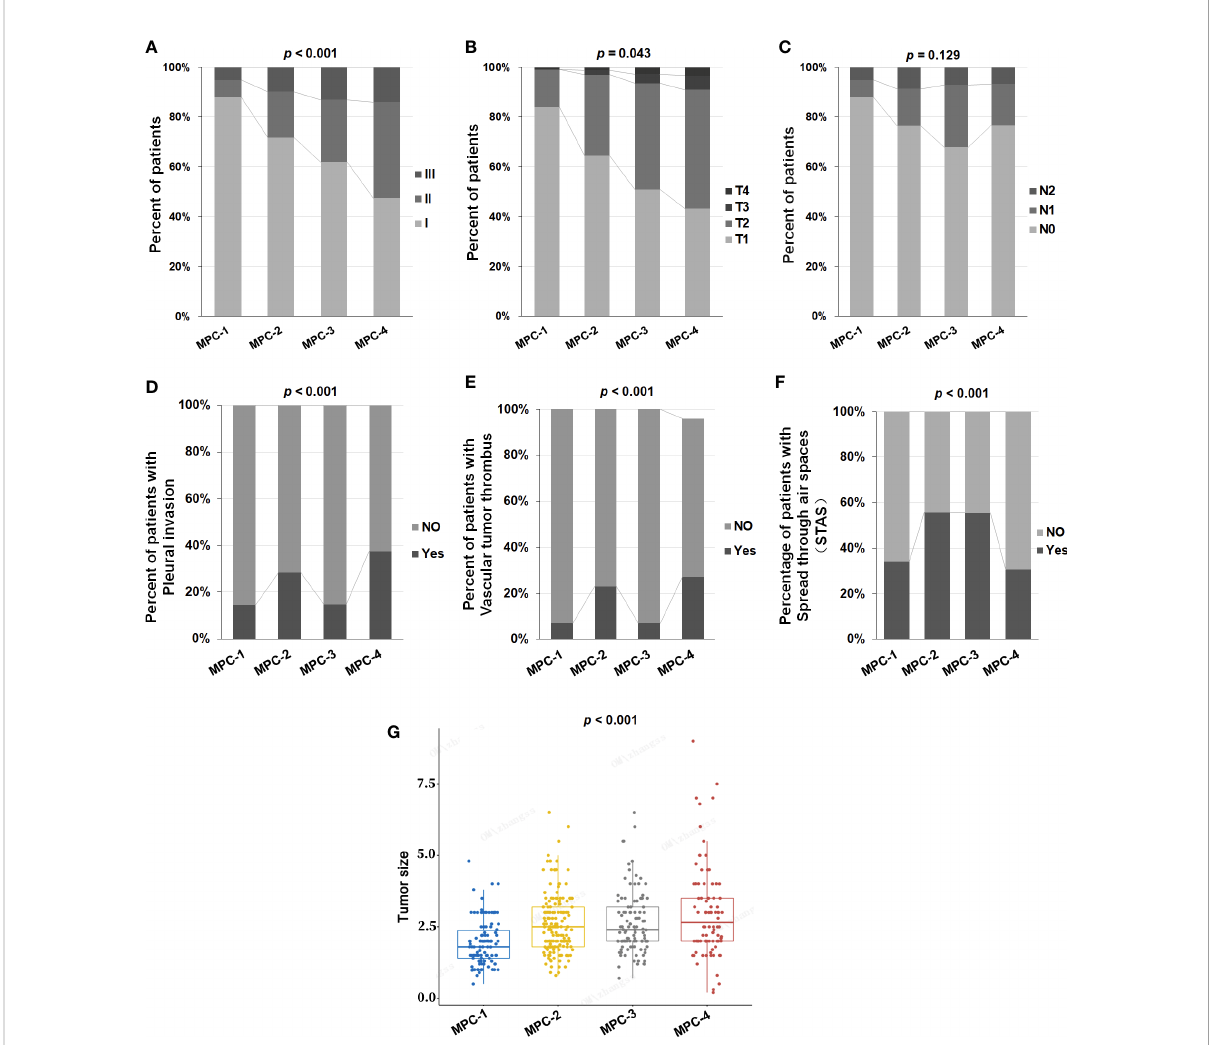
FIGURE 1 The correlation between different proportions of MPC and clinicopathological features in LAMPC patients. The correlation between different proportions of MPC and (A) stage, (B) T status, (C) N status, (D) pleural invasion, (E) vascular tumor thrombus, (F) spread through air spaces (STAS) and (G) tumor size. p< 0.05 was considered statistically signi fi cant, and p < 0.01 was considered more statistically signi fi